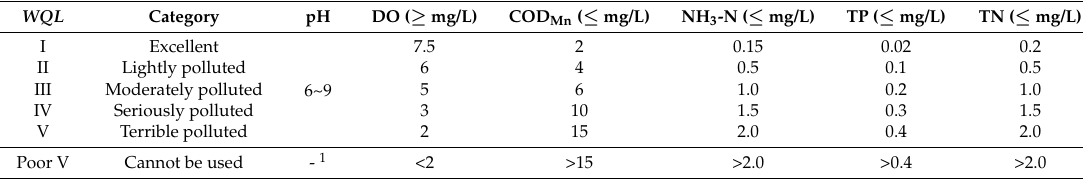
Table 1. The grading thresholds for several water quality indices.